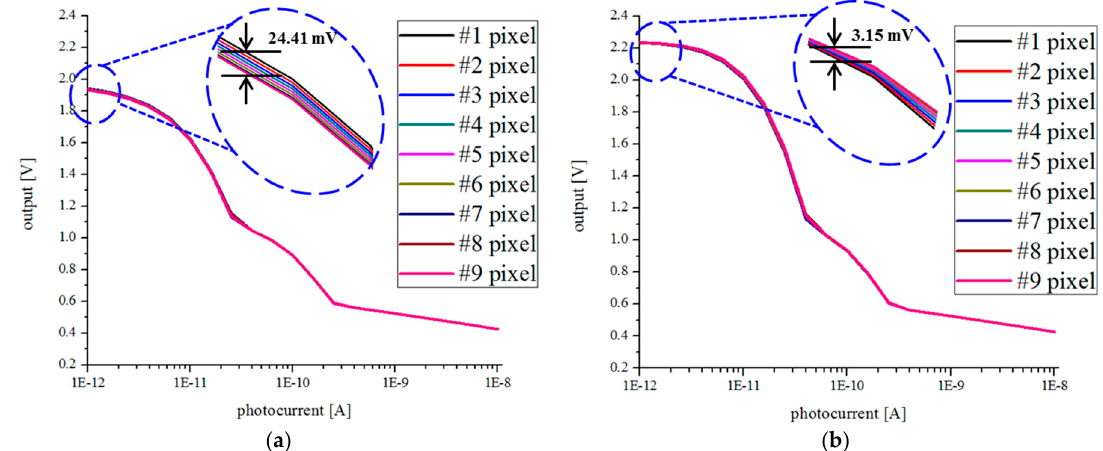
Figure 2. Simulation results of output curves according to the reset method; ( a ) conventional linear-logarithmic pixel and ( b ) proposed linear-logarithmic pixel.